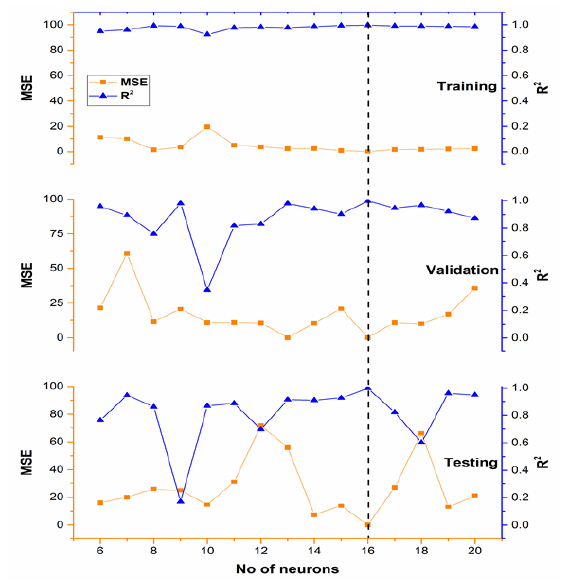
Figure 6. Variations in MSE and R 2 values with number of neurons.